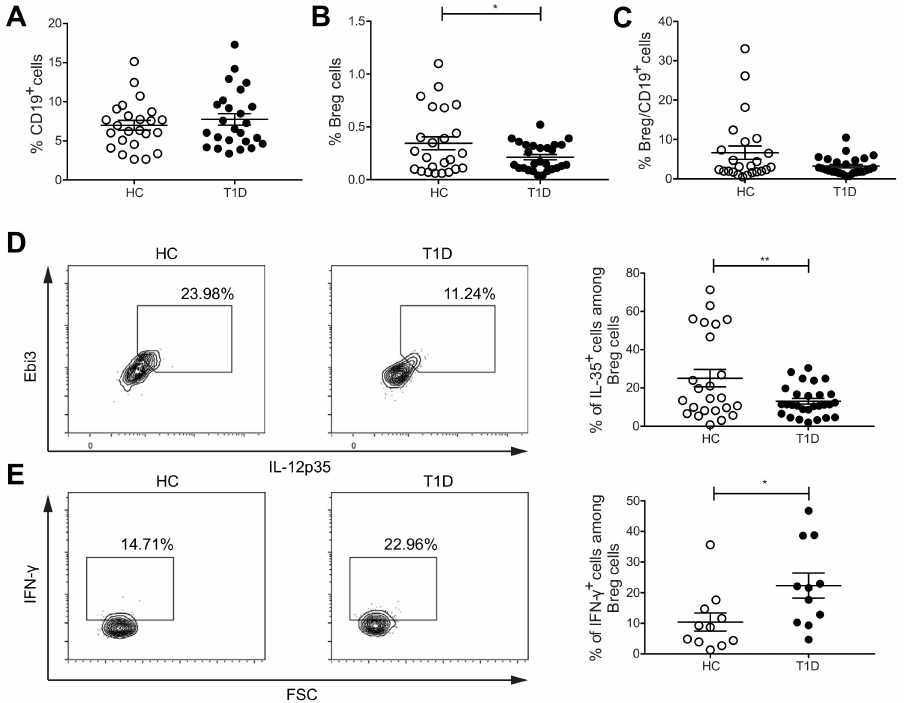
Figure 1. Proportions of IL-35 + and IFN- γ + Breg cells are altered in subjects with T1D com- pared with healthy controls (HC). PBMCs were isolated from peripheral blood of subjects with T1D and HC. Cell proportions were determined by flow cytometry. ( A ) The proportions of CD19 + cells. ( B ) The proportions of CD19 + CD24 + CD40 + CD38 + Breg cells. ( C ) The proportions of CD19 + CD24 + CD40 + CD38 + Breg cells among CD19 + cells. ( D ) The proportions of IL-35 + cells among CD19 + CD24 + CD40 + CD38 + Breg cells and representative dot plots. ( E ) The proportions of IFN- γ + cells among CD19 + CD24 + CD40 + CD38 + Breg cells and representative dot plots. Results are expressed as means ± SEM. Mann–Whitney tests were performed for ( C , E ). Unpaired t -tests were performed for ( A , B , D ). * and ** denote p < 0.05 and p < 0.01,